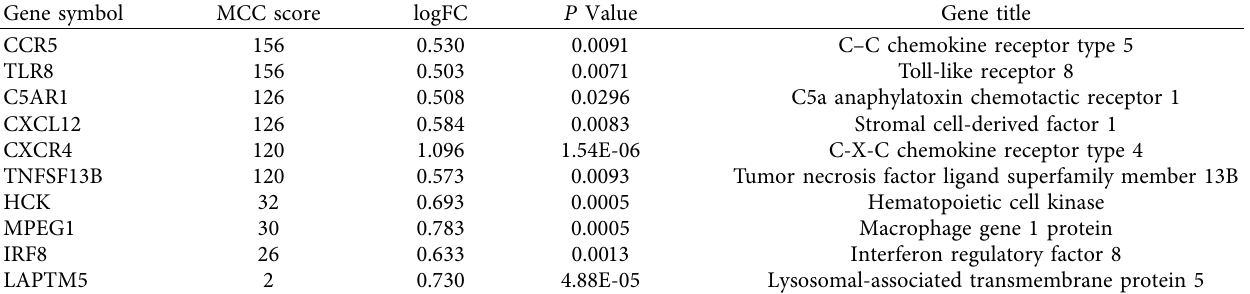
Table 1: Top 10 genes with higher MCC score in protein-protein interaction network.